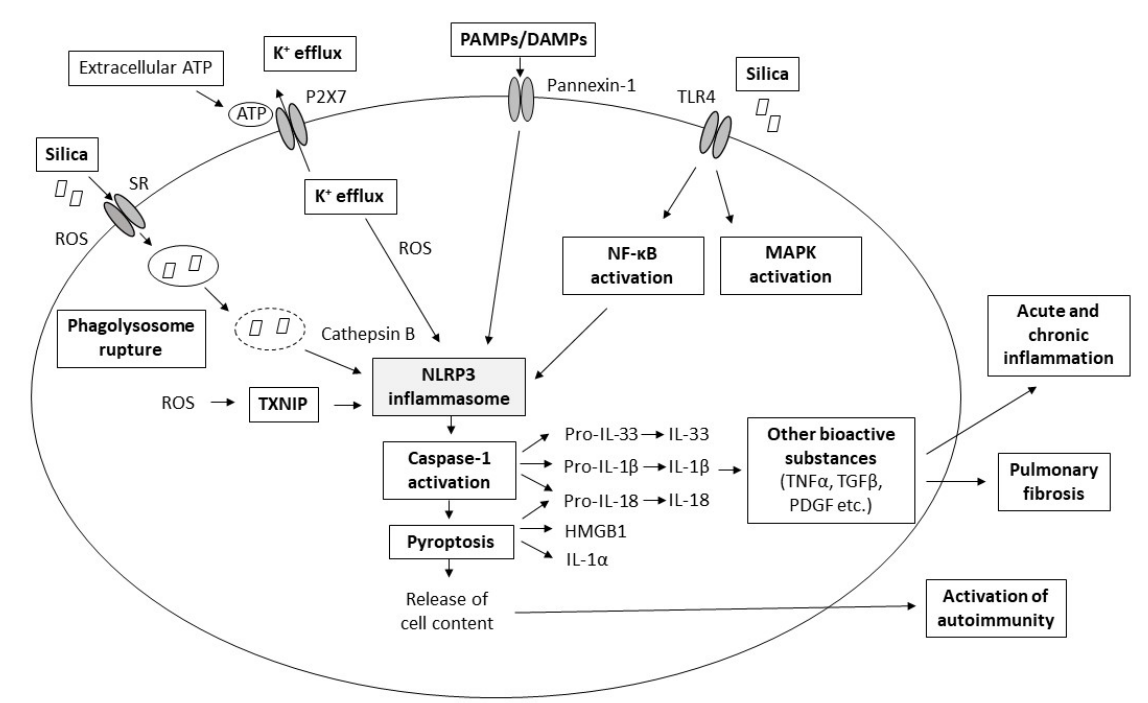
Figure 1. Scheme of major proposed pathomechanisms of pulmonary silicosis. More details about the individual pathomechanisms are provided in the following text. Abbreviations: ATP: adenosine triphosphate, DAMPs: danger-associated molecular patterns, HMGB1: high mobility group box 1 protein, IL: interleukin, K + : potassium cations, MAPK: mitogen-activated protein kinase, NF-κB: nuclear factor kappa B, PAMPs: pathogen-associated molecular patterns, PDGF: platelet-derived growth factor, ROS: reactive oxygen species, SR: scavenger receptors, TGFβ: transforming growth factor beta, TLR: Toll-like receptor, TXNIP: thioredoxin-interacting protein.